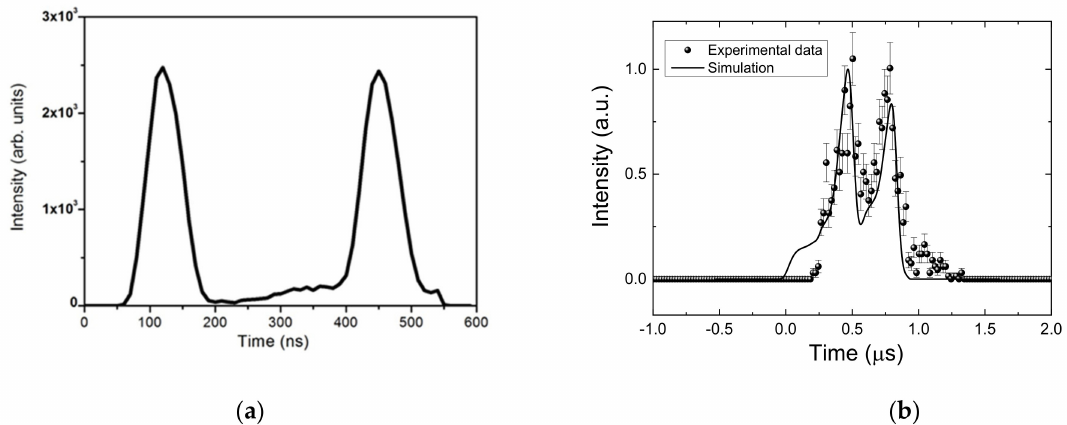
Figure 16. ( a ) Time structure of the double proton bunch from the ISIS synchrotron impinging onto the spallation target for neutron production; ( b ) normalized experimental neutron ToF spectrum recorded by diamond detector and the corresponding